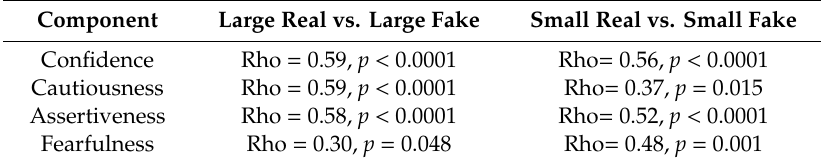
Table 3. Spearman’s rank correlation test comparing dogs’ reactions to real versus fake dog.